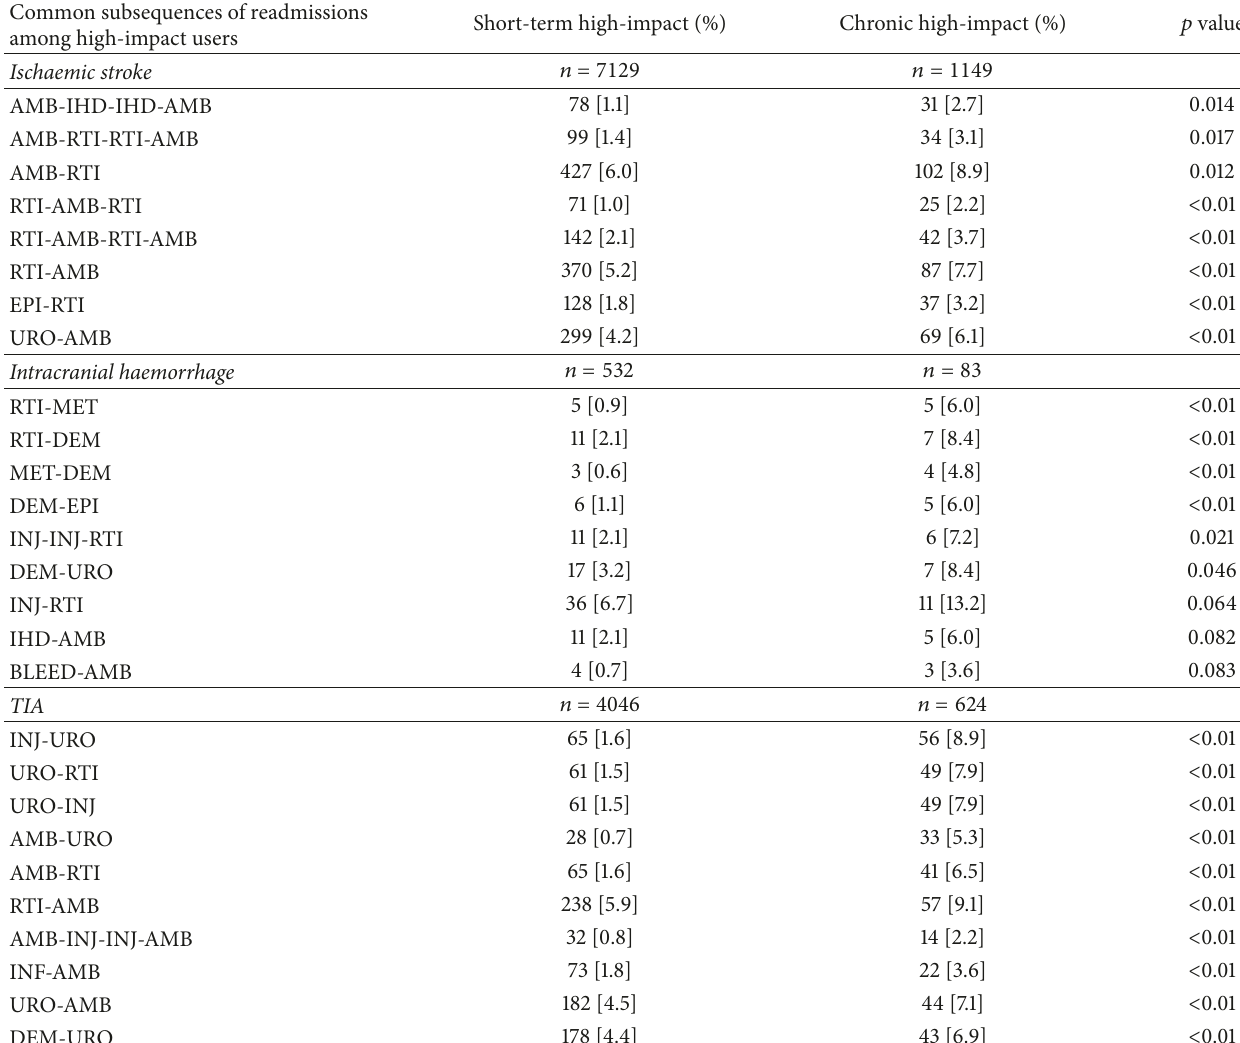
Table 4: Comparison of common subsequences among groups of high-impact users in the cerebrovascular conditions (urine infection and urological conditions [URO], respiratory tract infection [RTI], external injuries [INJ], ambulatory conditions [AMB], dementia [DEM], ischaemicstroke[IS],epilepsy/seizure[EPI],ischaemicheartdisease[IHD],otherinfectionsandinflammationoforgans/skin[INF],bleeding complications [BLEED], and metabolic and nutritional disorders